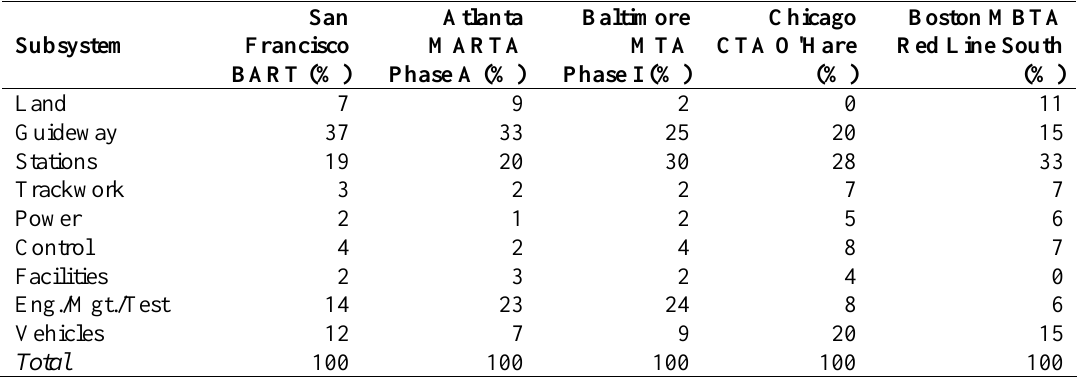
Table 7. Breakdown of metro capital costs by subsystem for five US metros. Subsystem